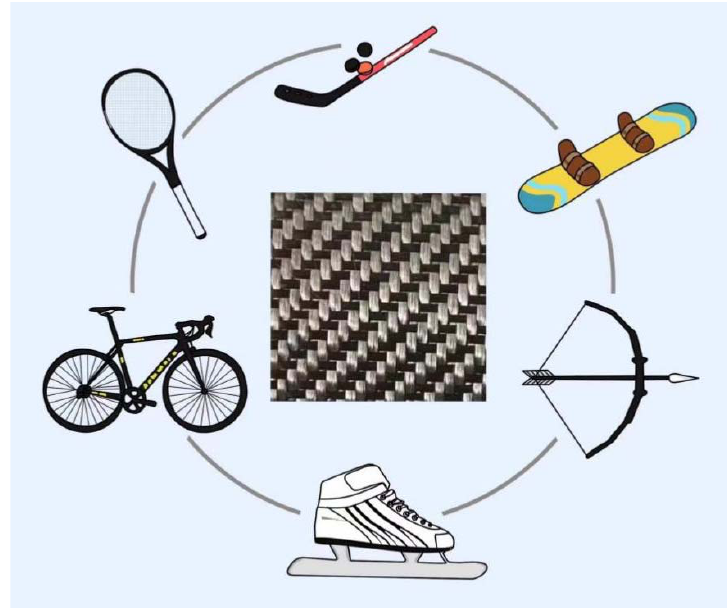
Figure 4. CFC applied in the manufacture of sports equipment.